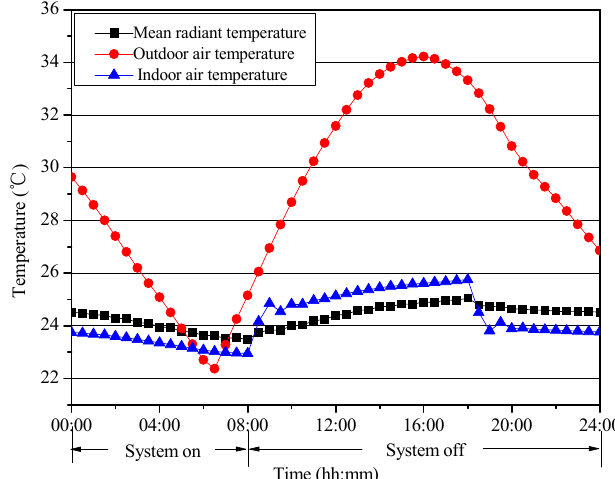
Figure 6. Variation trends of indoor and outdoor air temperature and mean radiant temperature on 10 10 July.